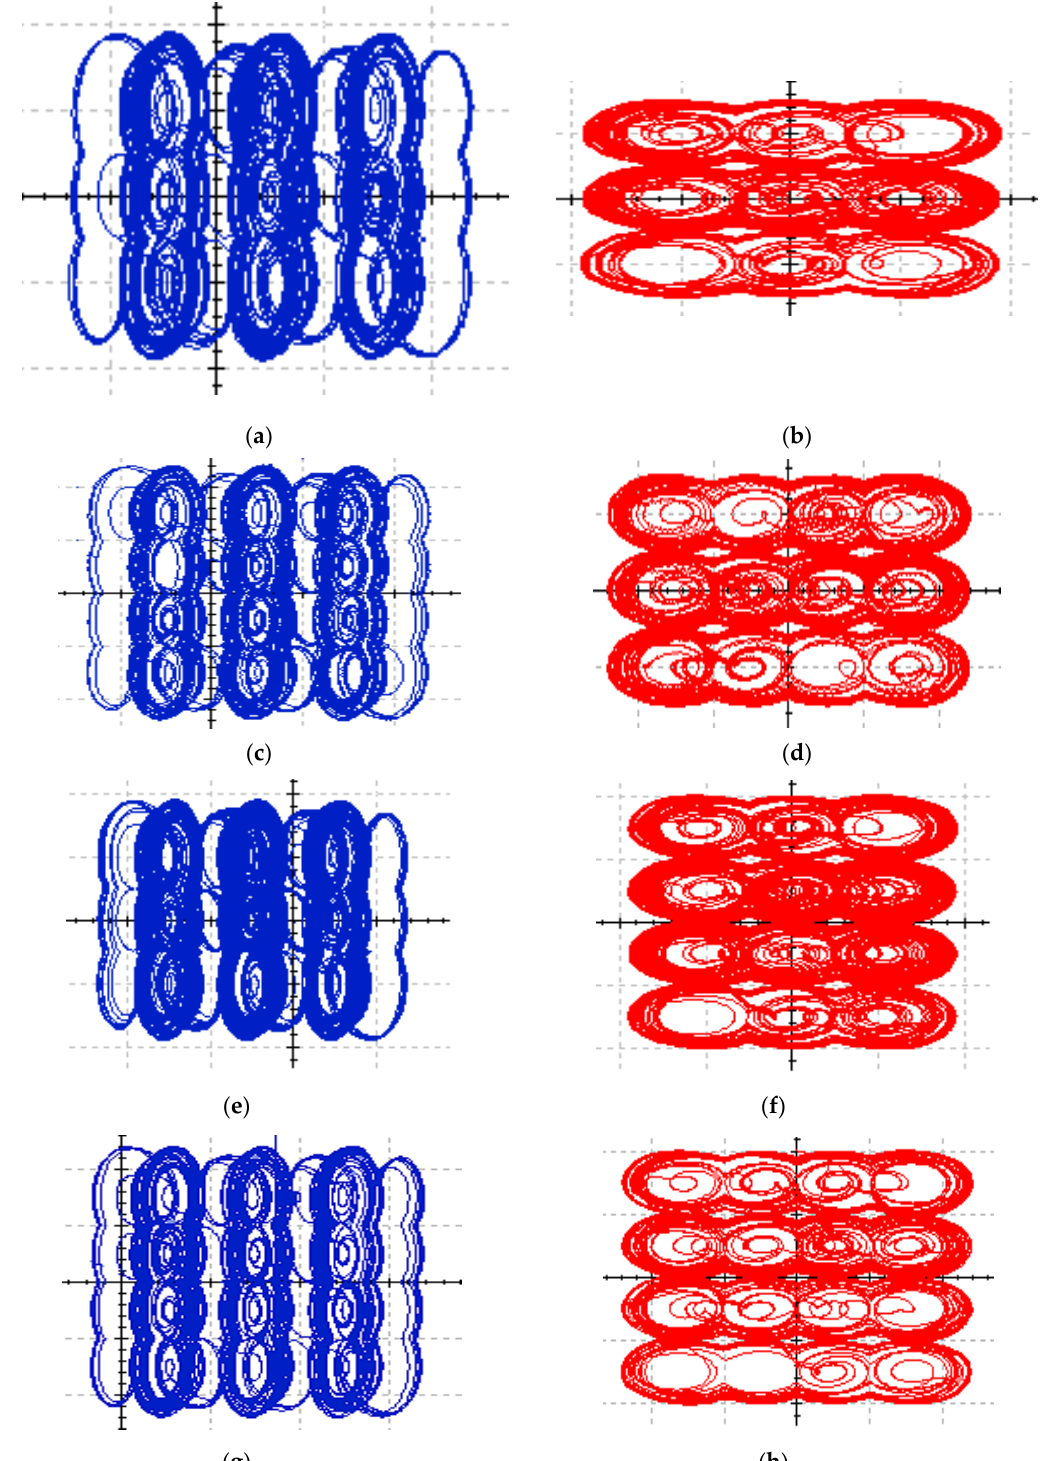
Figure 13. (Color online) The circuit simulation results correspond to Figures 5–8, respectively: ( a , c , e , g ) are the x–y plane and ( b , d , f , h ) are the y–z plane.